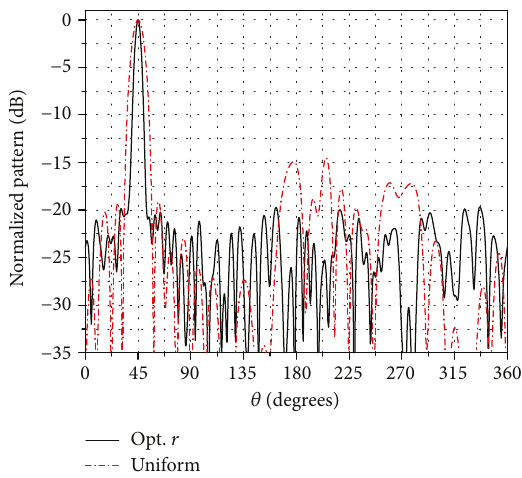
Figure 4: Comparison of normalized power patterns generated by the proposed C-BFN con fi guration with a uniform and nonuniform concentric ring array, optimizing r